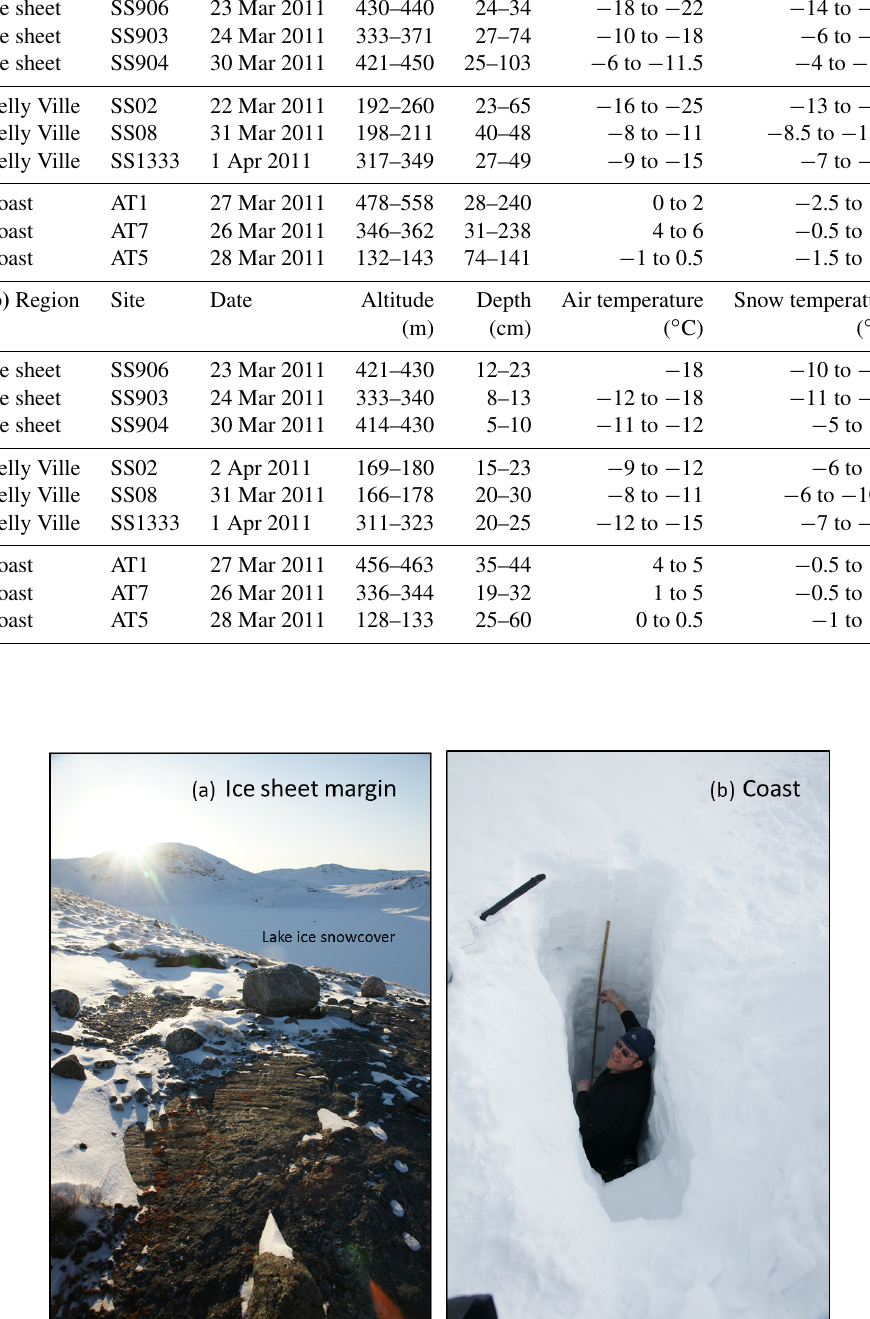
Figure 2. (a) Typical sublimating snowpack close to the ice sheet and lake ice snow cover on lake SS903 (24 March 2011), (b) contrasting with deep snow profile on lower catchment slope of coastal site AT7 2 days later (26 March